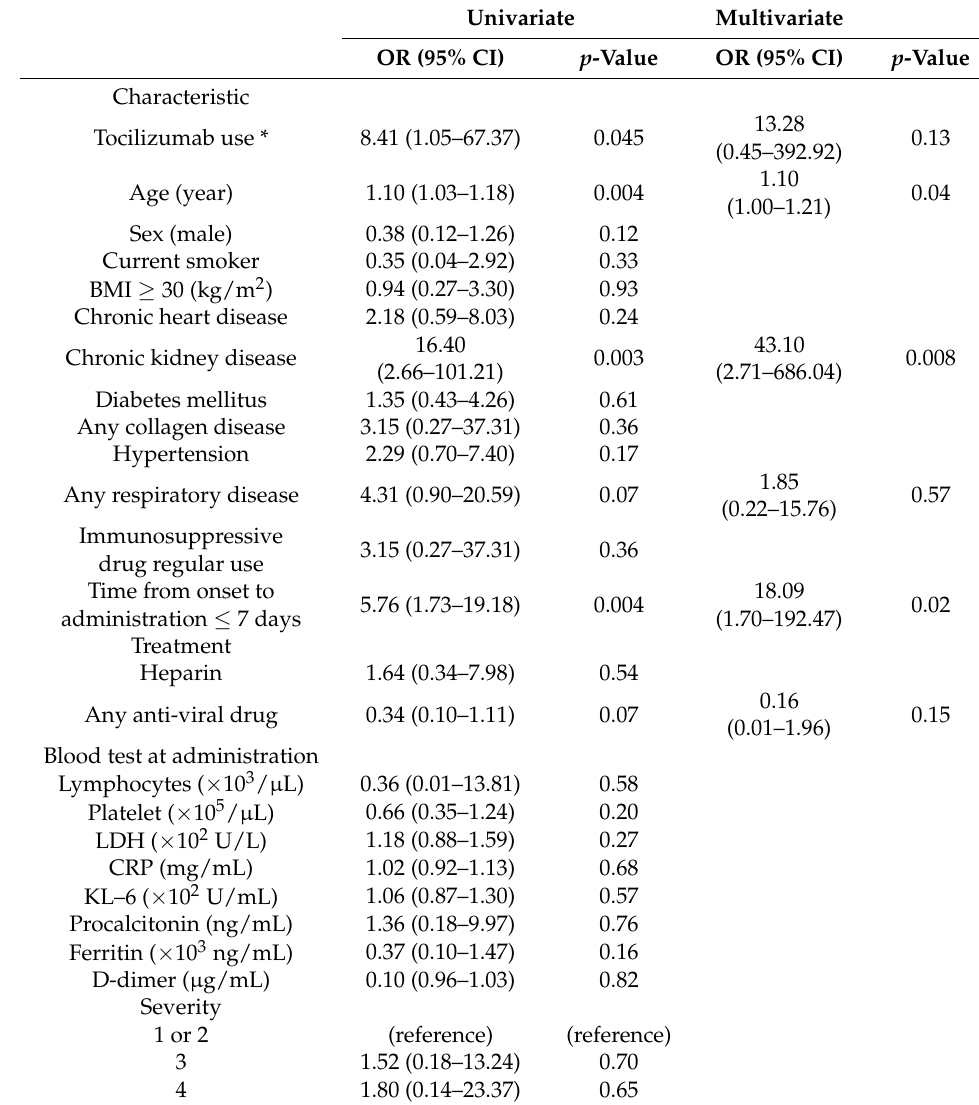
Table 2. Mortality predicting factors among patients within 28 days from treatment with tocilizumab or baricitinib.